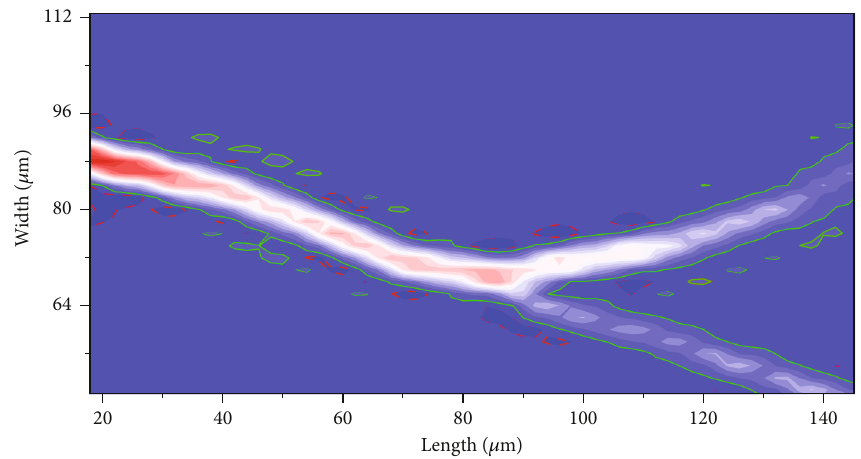
Figure 11: The partial enlarged view of shadow region in Figure